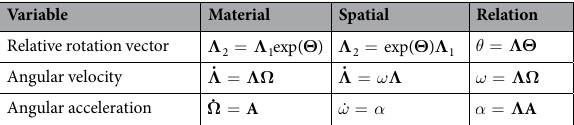
Table 2. Relations between material and spatial representations of